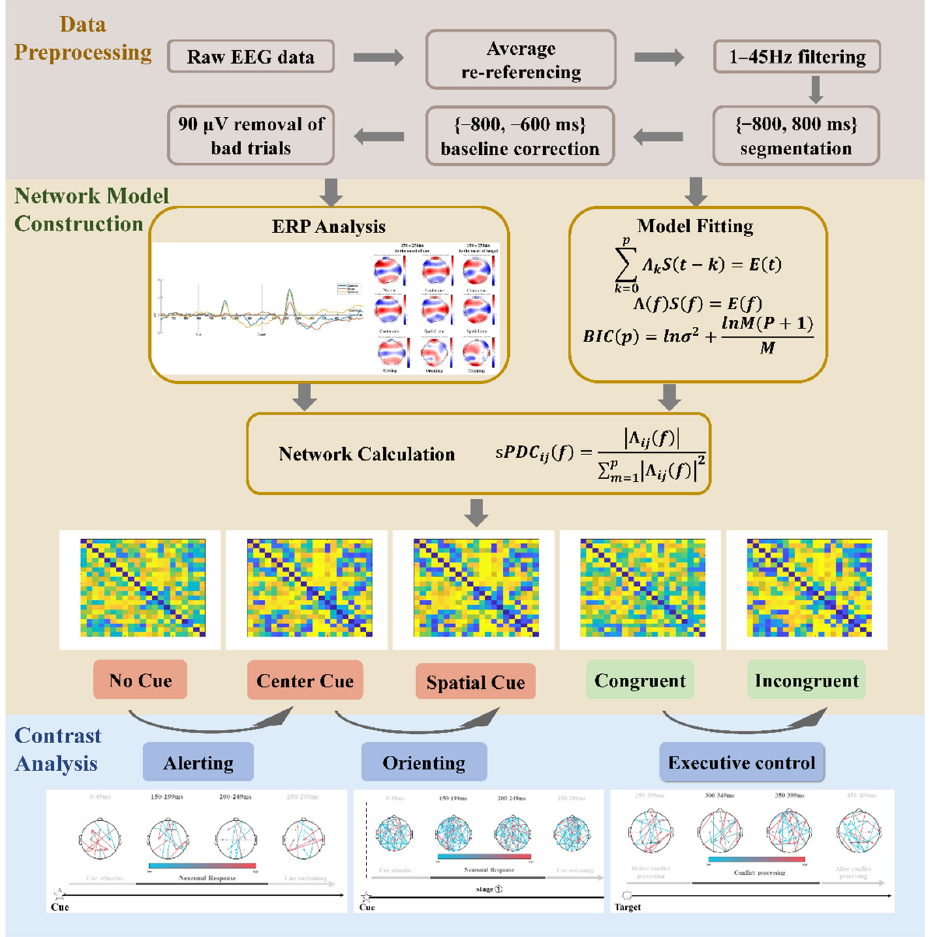
Figure 2. The pipeline of data processing, consists of EEG data preprocessing, ERP analysis, brain network construction and the contrast analysis for each of attention network.